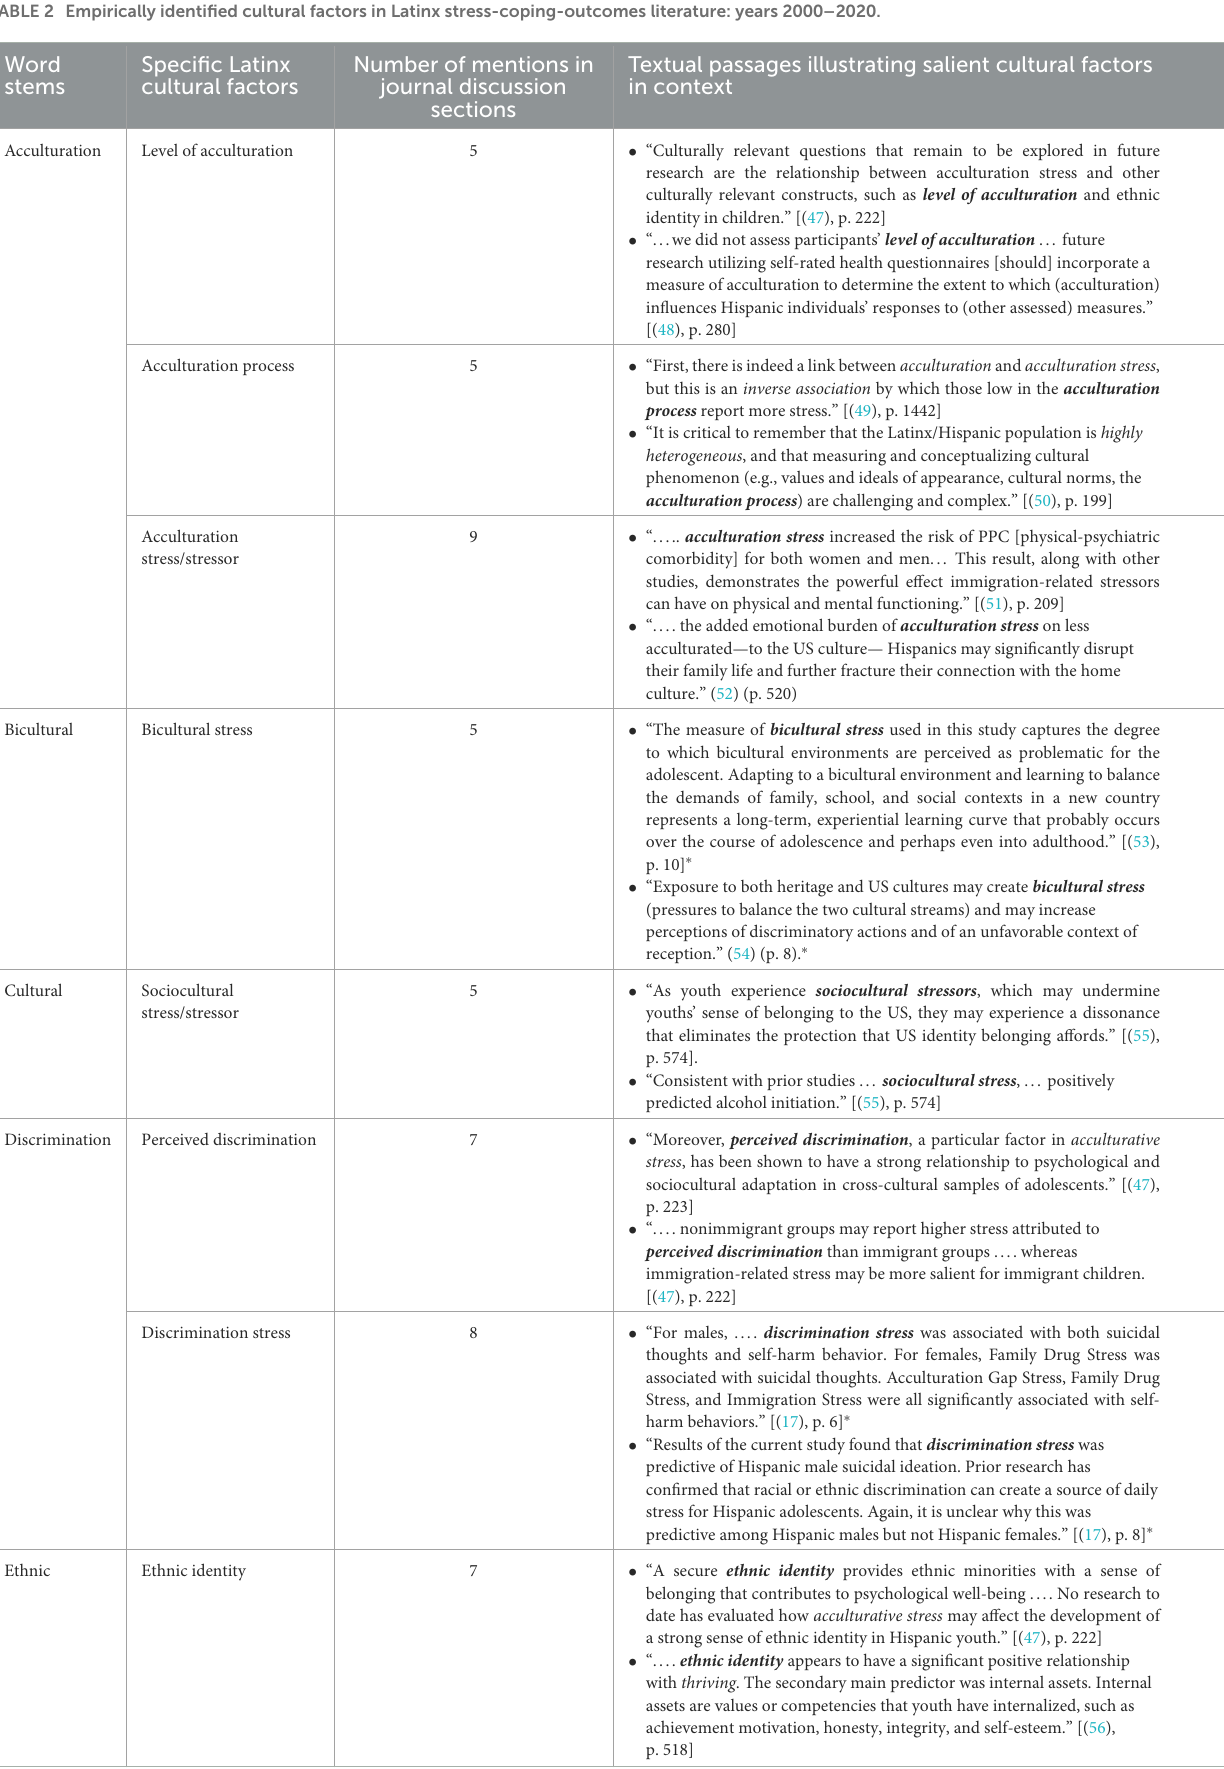
TABLE 2 Empirically identified cultural factors in Latinx stress-coping-outcomes literature: years